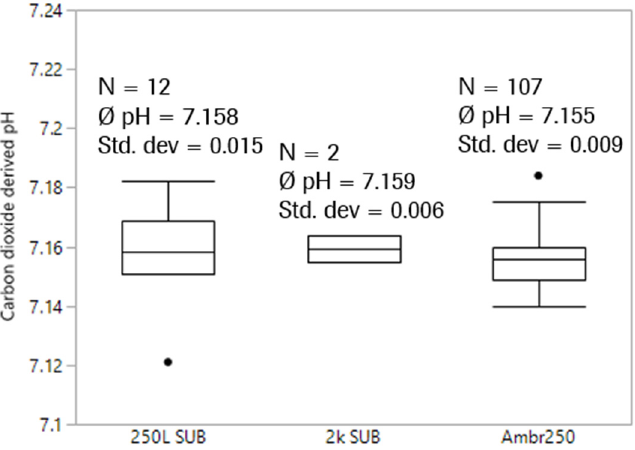
Figure 8. Comparison of carbon dioxide-derived pH after media fill before inoculation between scales and plants. pH offline values for 2k SUBs had an offset of 0.009 and 0.046, respectively.